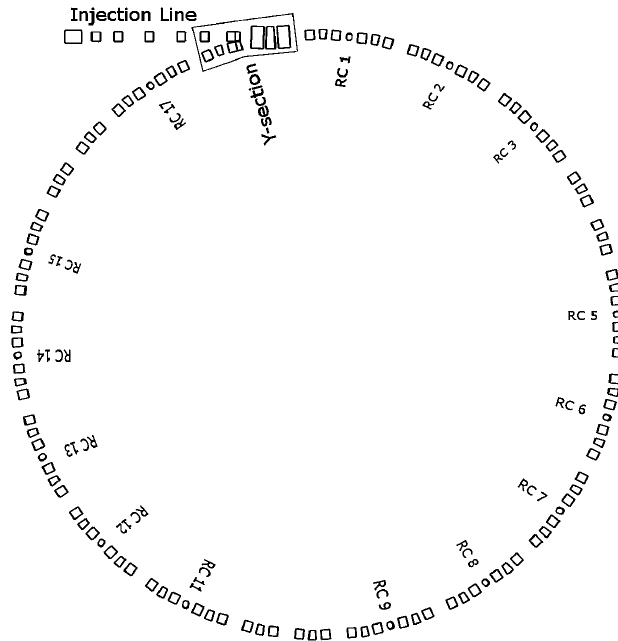
FIG. 1. A simplified diagram of the ring made using COSY INFINITY ’s graphics package. The sections labeled RC1, 2, etc. have diagnostic chambers containing phosphor screens and beam position monitors. RC4, 10, and 16 do not have beam position monitors to make room for other